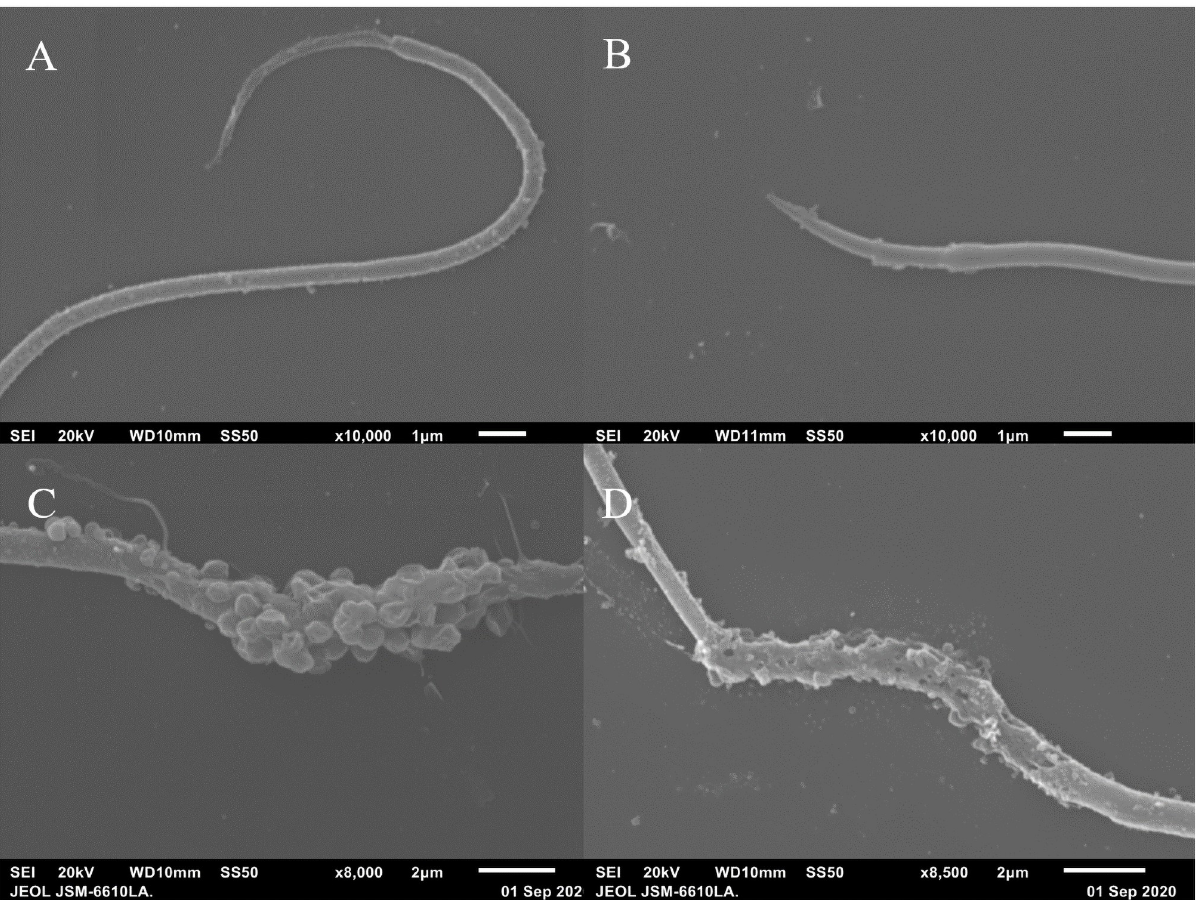
Fig 6. Tuatara sperm tail tips and midpiece damage ( Sphenodon punctatus) , visualized using SEM. Photographs of Sphenodon punctatus sperm treated with Lake’s solution and viewed using scanning electron microscopy, showing (A + B) reduced tail tips and (C + D) different types of midpiece damage, likely due to ineffective cryoprotectant during freezing and